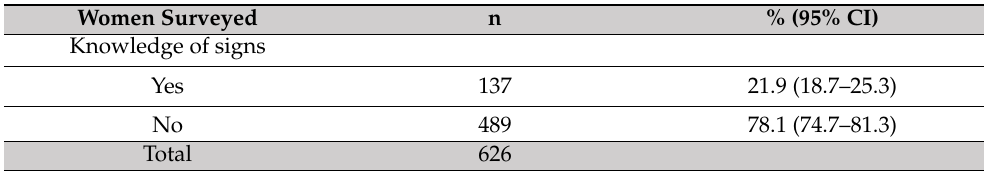
Table 4. Knowledge of ODS among pregnant